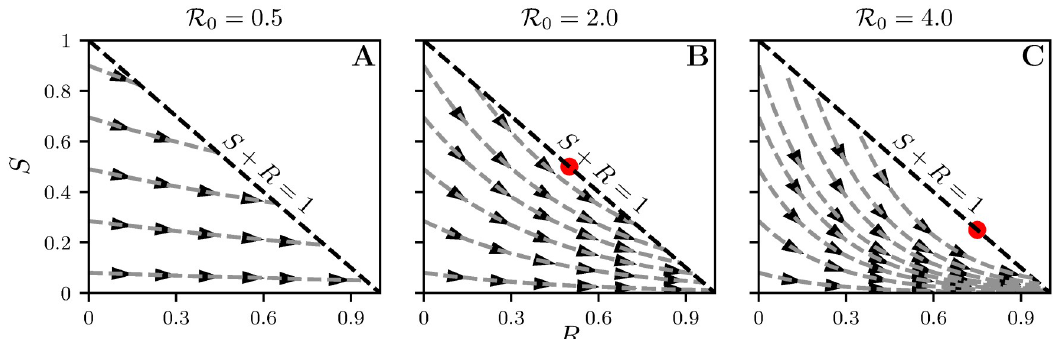
Fig 10. We plot S ( t ) versus R ( t ) for R = 0.5 A, 2 B, and 4 C. For given S ( t ) and R ( t ), the proportion infected is I ( t ) = 1 − S ( t ) − R ( t ), 0 which equals the vertical or horizontal distance from the point ( R ( t ), S ( t )) to the line S + R = 1. The curves and arrows show how a solution to System (1) evolves in time. At points S > 1 = R (which occurs only for R > 1 ) curves move farther from the diagonal, 0 0 representing an increase in I . Note that the velocity a curve is traversed varies depending on location, and goes to zero close to , I = 0, R = 1 − S ). S + R = 1. Red dots in B–C indicate the point ( S ¼ 1 R 0